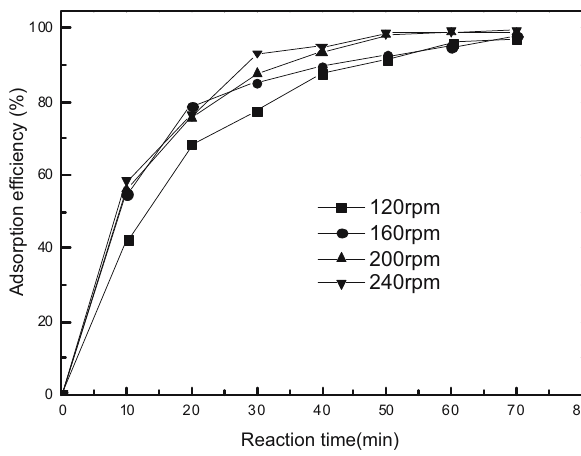
Figure 2: E ff ect of shaking speed on the adsorption e ffi ciency for GPC by 001 × 7 cation - exchange resin.